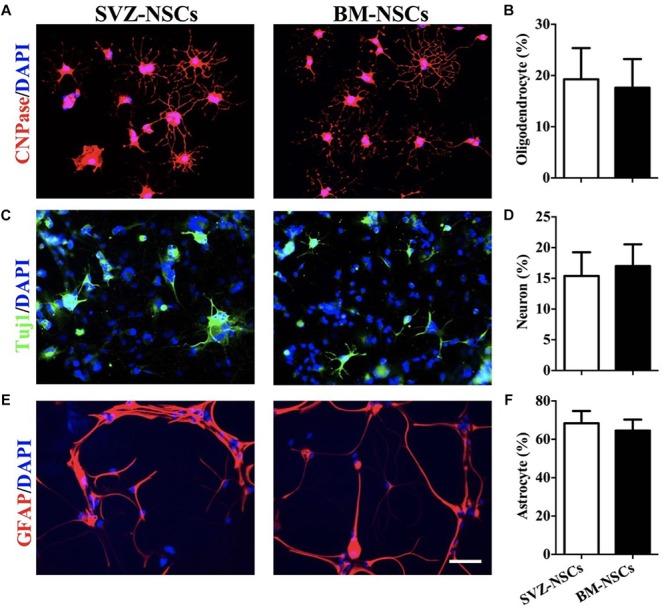
BM-NSCs differentiation in vitro. Examples of NSCs that differentiated into (A) OLGs (CNPase+), (C) neuron (Tuj1+), and (E) astrocytes (GFAP+), after 1 week with specific differentiation media. Scale bar = 50 μm. (B,D,F) Quantitative analysis of differentiated cells. Data are shown as mean values ± SD (n = 5 each group) and are representative of three experiments. Significance difference was analyzed by Student’s t-test.